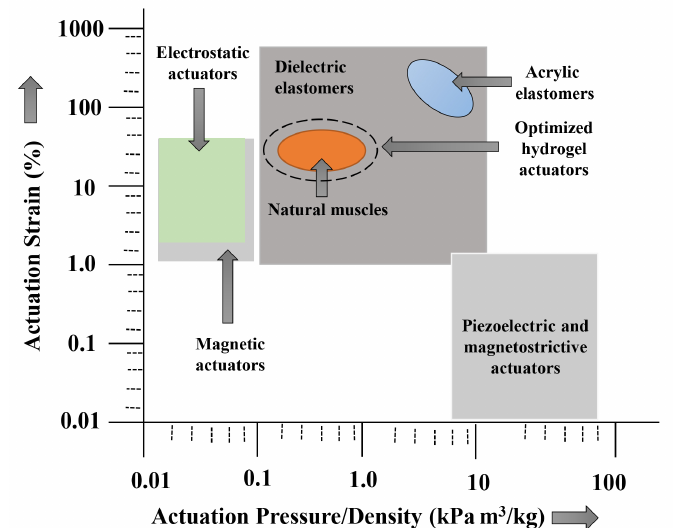
Figure 1. Different regimes of soft actuators and natural muscle. Optimized hydrogel actuators closely mimic artificial muscles’ tissue